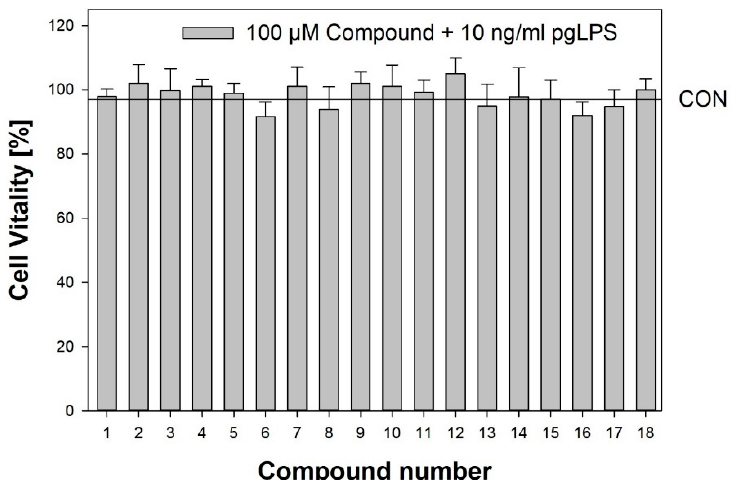
Figure 1. Cell vitality upon 6 h incubation of human gingival fibroblasts (HGF-1) cells with 10 ng/mL lipopolysaccharides (LPS) and 100 µM of the respective compound. Shown are average ±SD compared to untreated cells. The horizontal line marks the vitality of cells treated with 0.1% DMSO only. Significant differences between treatment and control were tested using the Student’s t -test.